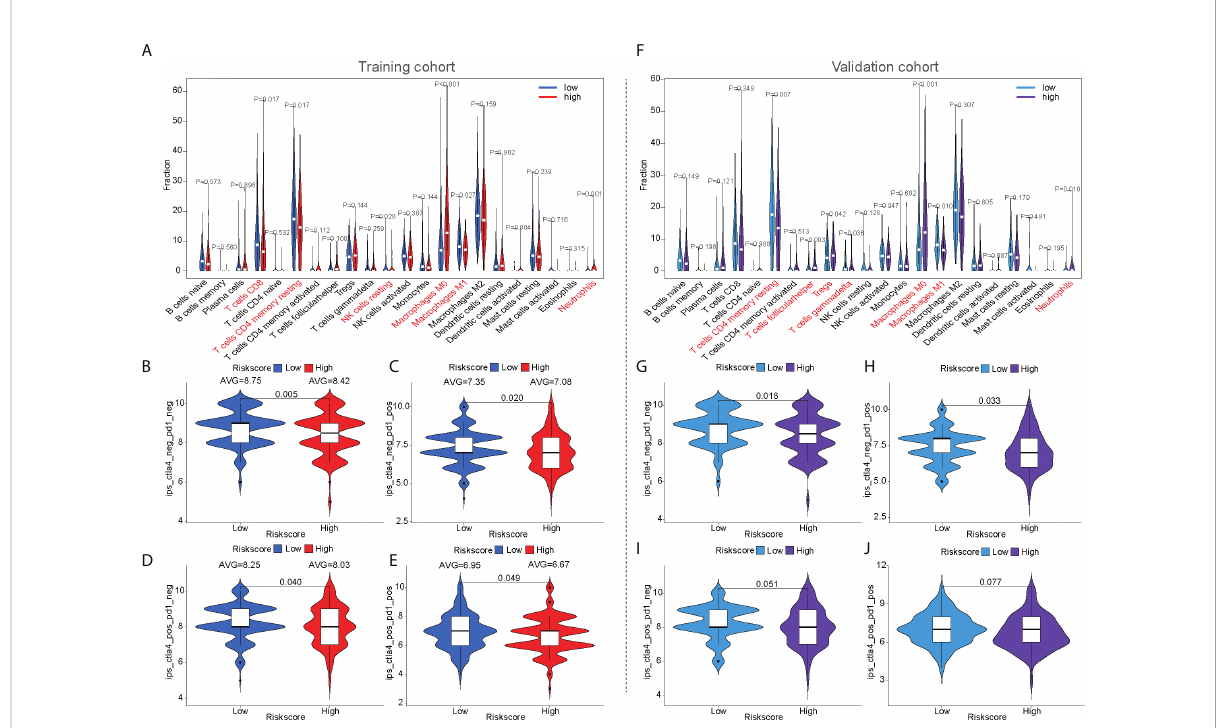
FIGURE 6 The prediction of immunotherapeutic response based on mfrlncRNA signature. (A) The in fi ltration of 22 immune cells according to CIBERSORT analysis between high- and low-risk populations in the training cohort. (B – E) IPS between high- and low-risk populations in the training cohort. (F) The in fi ltration of 22 immune cells in the validation cohort. (G – J) IPS between high- and low-risk populations in the validation cohort. CIBERSORT, Cell-type Identi fi cation by Estimating Relative Subsets of RNA Transcripts; IPS,